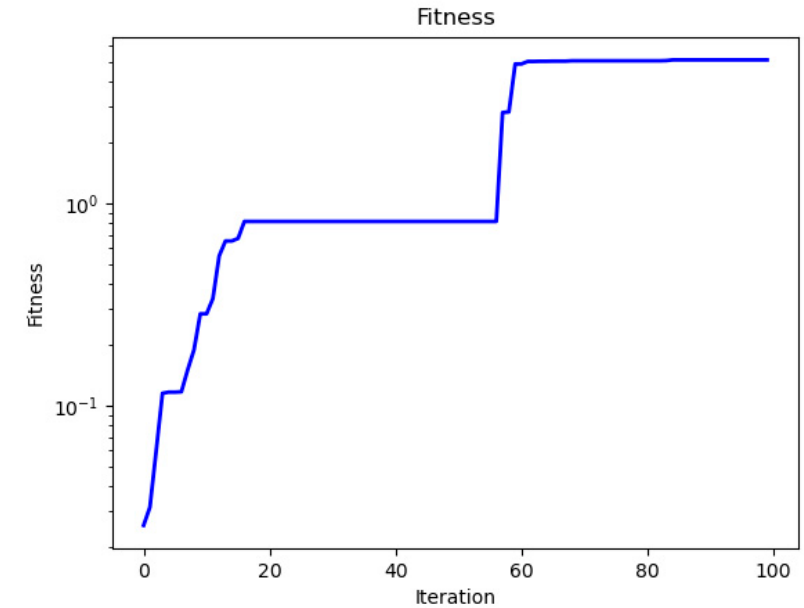
Figure 6. The iteration and corresponding fitness in dataset 2. The fitness and corresponding network hyperparameter at each iteration are shown in Table